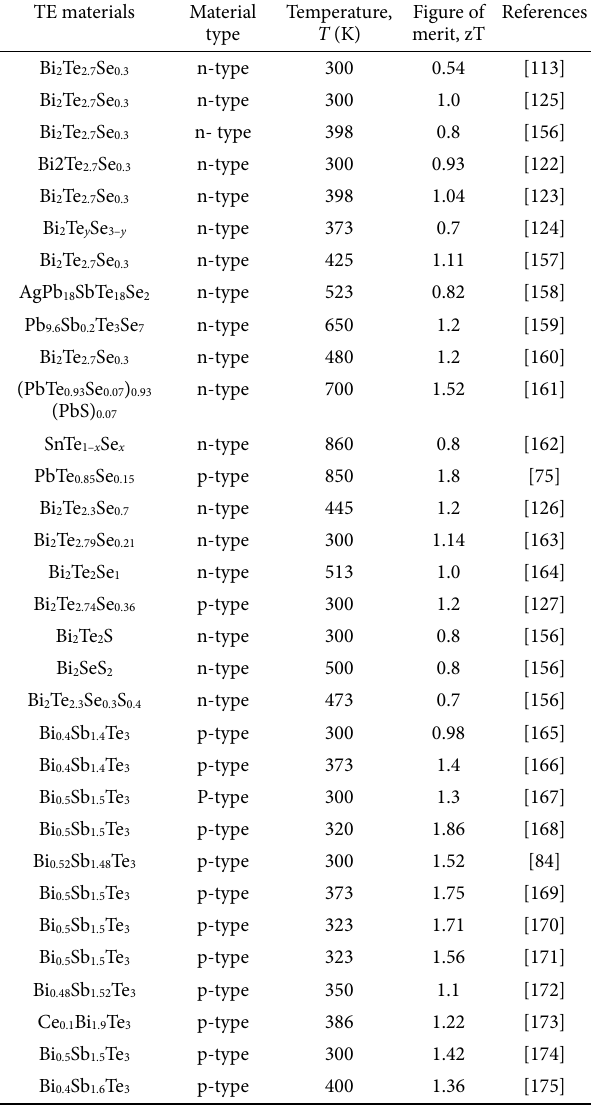
Table 4 Improvement in MC TE materials obtained through isovalent